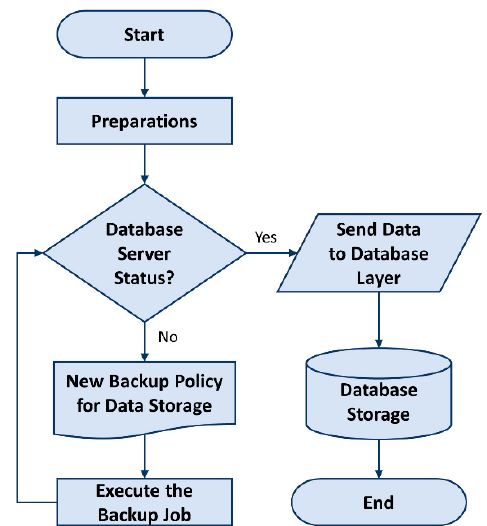
Figure 5. Flowchart for database recovery.